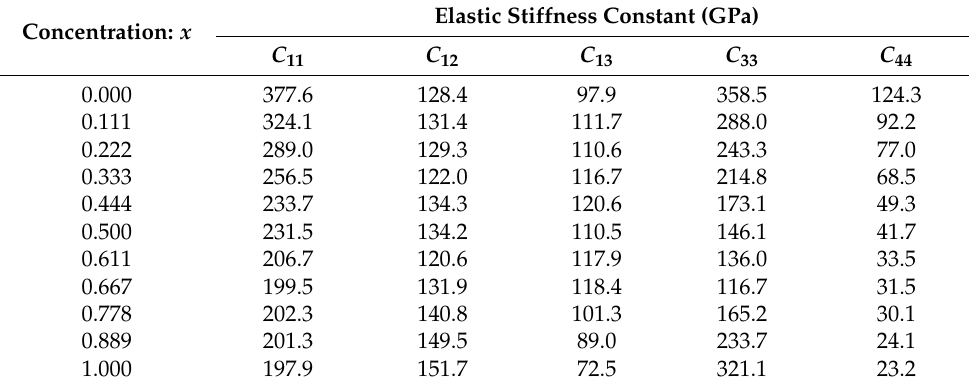
Table 1. Elastic stiffness constants of Yb x Al 1 − x